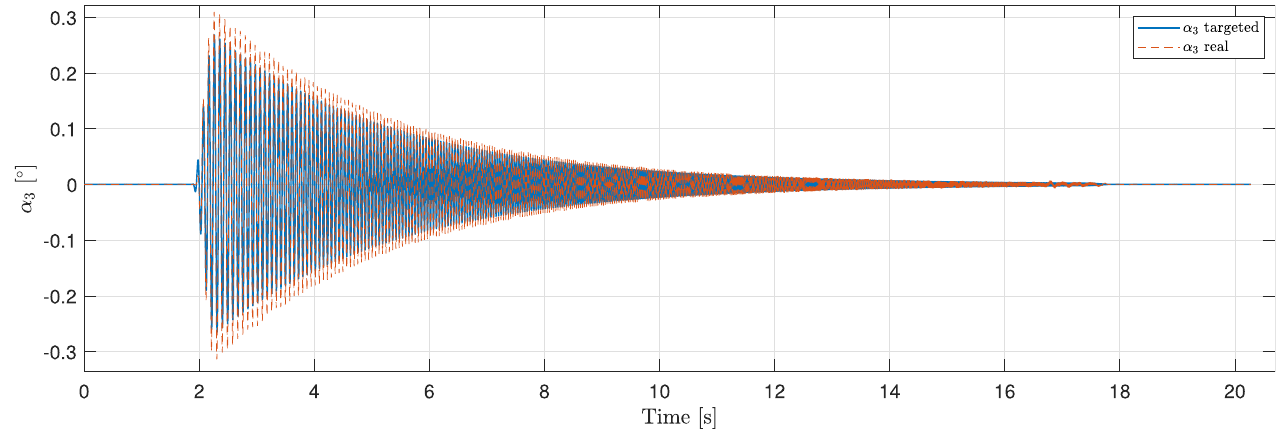
Fig. 10. Comparison between the targeted and real roll angle α 3 of the rotor base with a chirp sine profile.